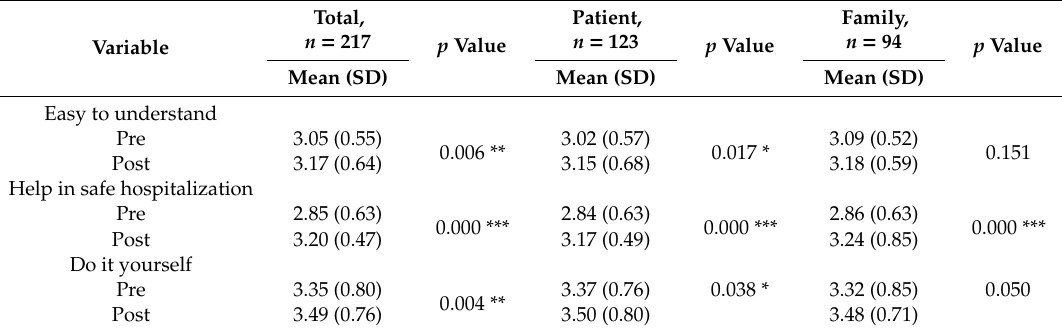
Table 3. Comparisons between patient safety literacy in pre- and